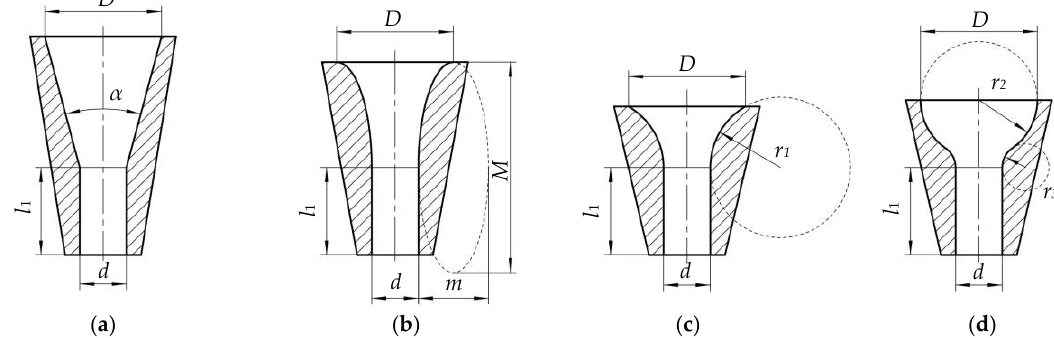
Figure 9. Structure of the nozzle shrinkage section. ( a ) conical, ( b ) elliptical, ( c ) single circular arc, ( d ) double circular arc. Where the nozzle inlet diameter D of 40 mm, the nozzle outlet diameter d of 16 mm and the nozzle shrinkage angle α of 30°.